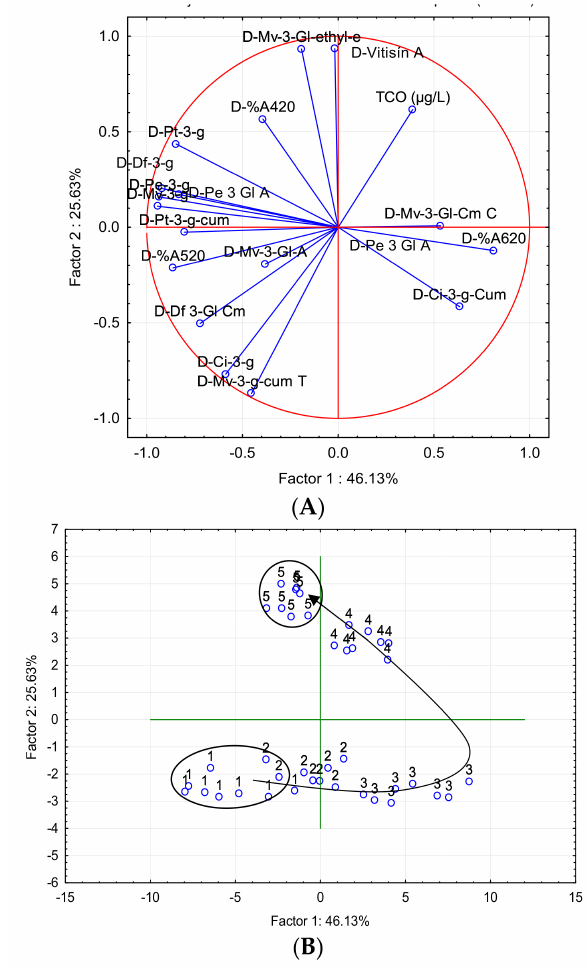
Figure 6. Principal component analysis (PCA) performed with individual anthocyanin compounds in wines from different micro-oxygenation and wood strategies. 1, 2, 3, 4, and 5: samplings carried out in each tank after 20, 48, 76, 97, and 111 days’ aging,